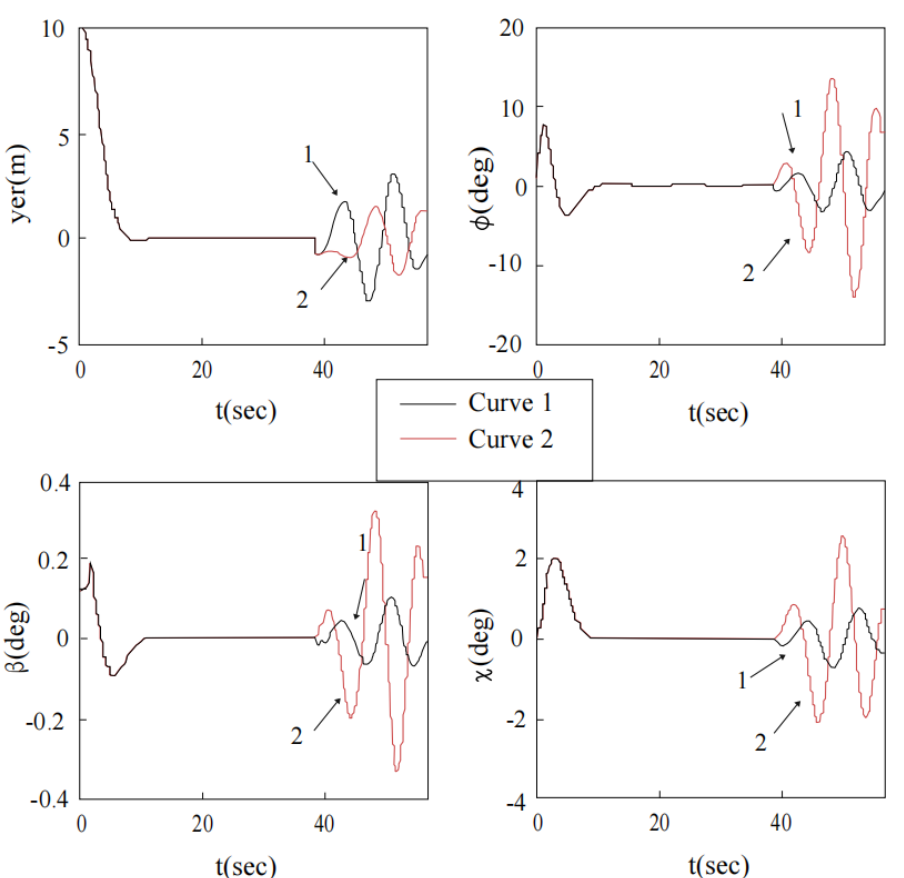
Figure 33. The curve of the compensation effects of ACLS Lat for deck motion with parallel compensation command of yaw and roll.